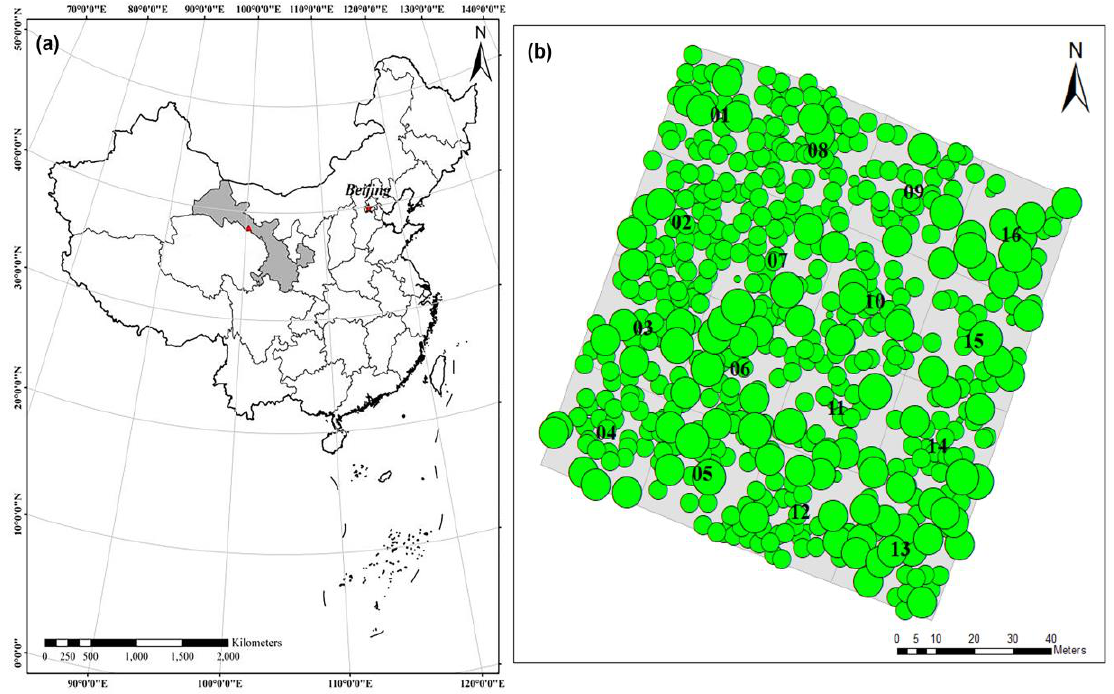
Figure 1. ( a ) Location of the study site: Xishui forest farm located in the Su’nan Yuguzu autonomous county of the Gansu Qilian Mountains National Nature Reserve, Western China and ( b ) tree positions within 16 sub-sample plots nested within a permanent sample plot of 100 × 100 m.